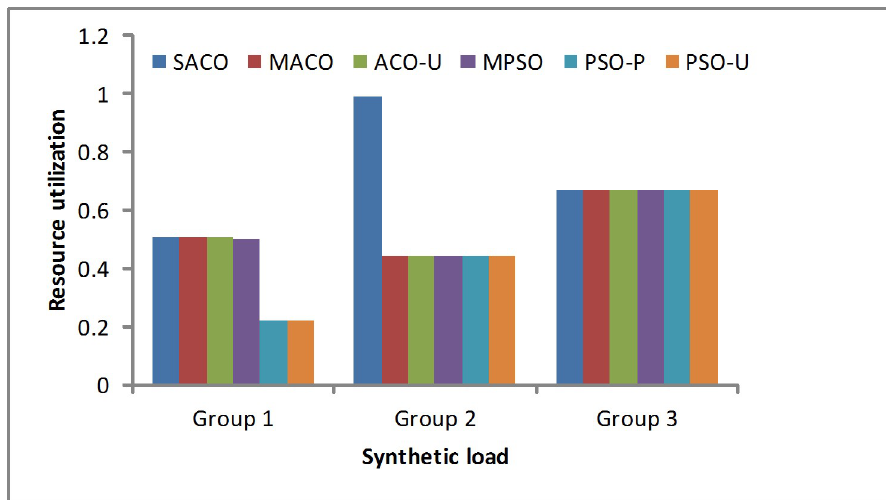
Fig 6. CPU resource utilization under the synthetic